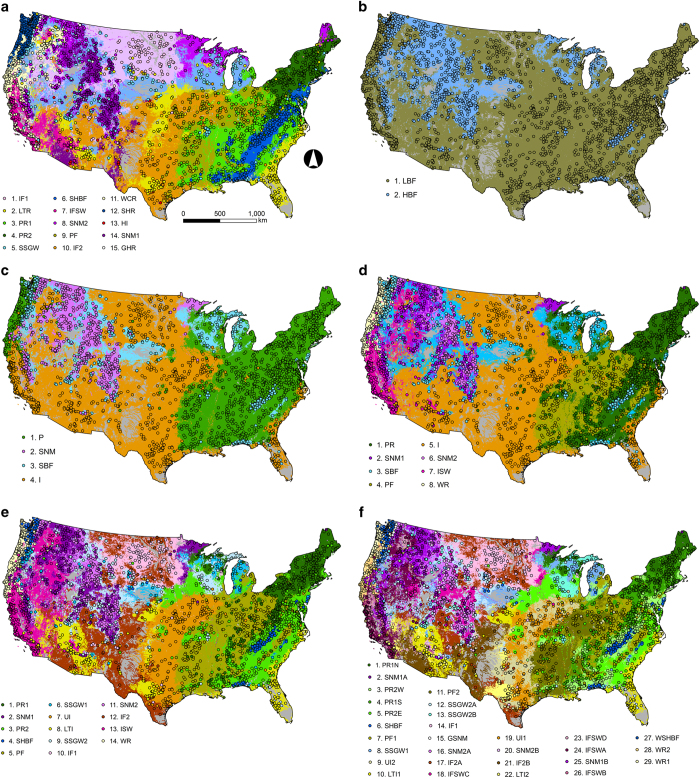
Maps of hydrologic classes assigned to stream reaches in the conterminous US.Different clustering approaches used developed hydrologic classes at stream gauges (points) were mapped to stream reaches including: (a) Fifteen gaussian mixture model classes, and several Ward’s agglomerative clustering solutions for (b) two, (c) four, (d) eight, (e) fourteen, and (f) thirty classes. Acronyms for classes are described in Tables 5 and 6.